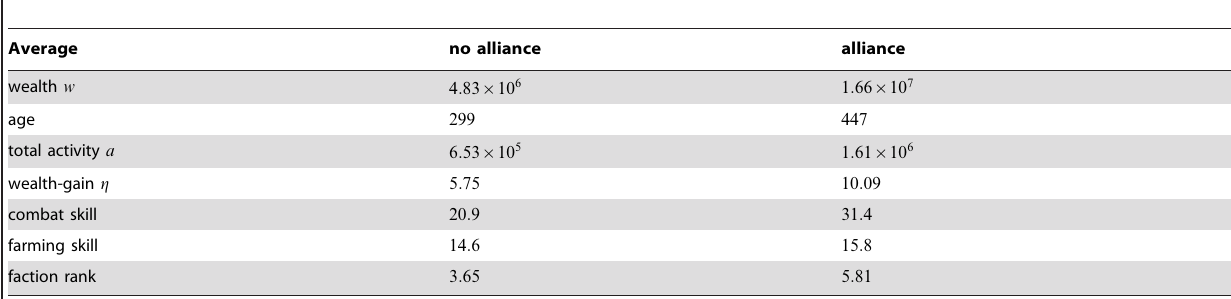
Table 3. Various properties of players versus their membership in alliances.